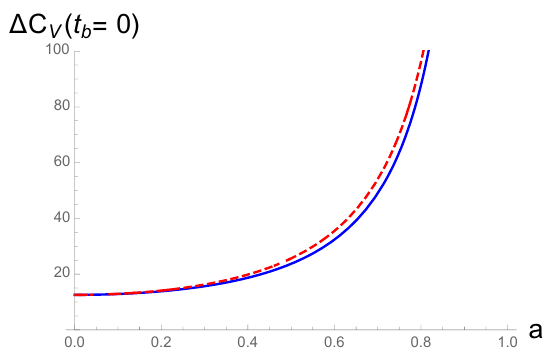
Figure 27 . In blue eq. (2.78) and in red dashed the BL result